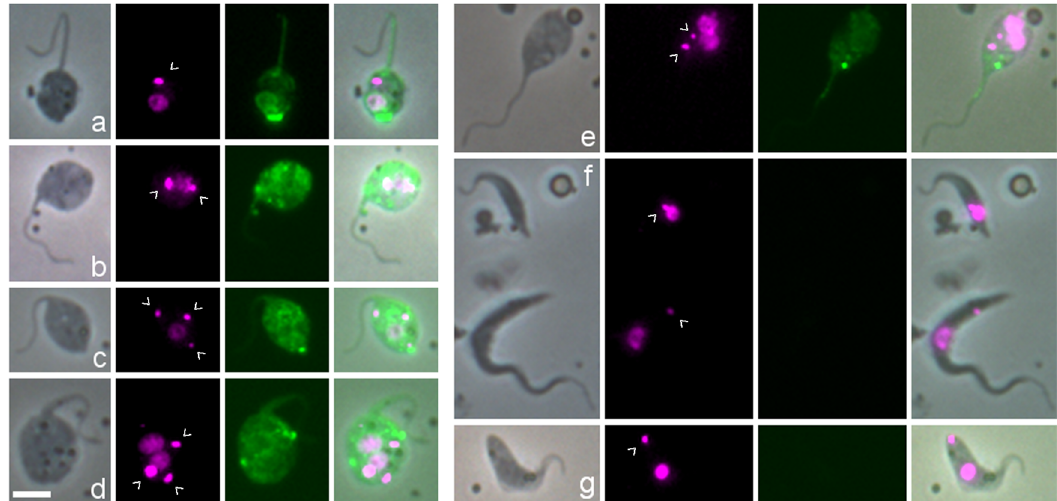
Fig. 6 Expression of HAP2::YFP in SG-derived T. b. brucei TREU 927. L to R: phase contrast, DAPI (magenta), YFP, merge. a – e Examples of individual trypanosomes expressing HAP2::YFP . Gametes: a 1K1N; b 2K1N. Potential meiotic intermediates: c 3K1N; d 3K2N; e 2K2N. Examples of non-expressing cells: f top, epimastigote; bottom, trypomastigote; g metacyclic. Kinetoplasts are indicated by arrowheads. Scale bar = 5 µ m.